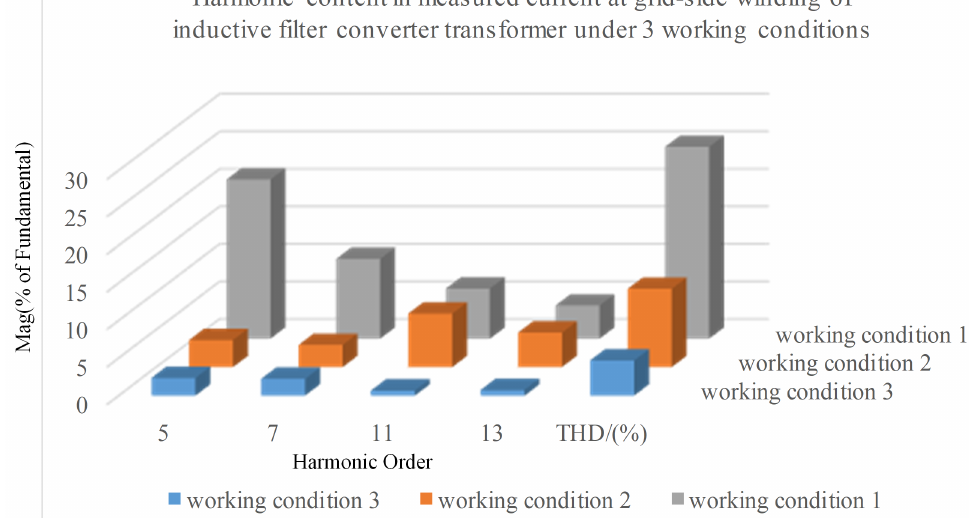
Figure 14. The histogram of harmonic content in measured current at the grid-side winding of the inductive filter converter transformer under three working